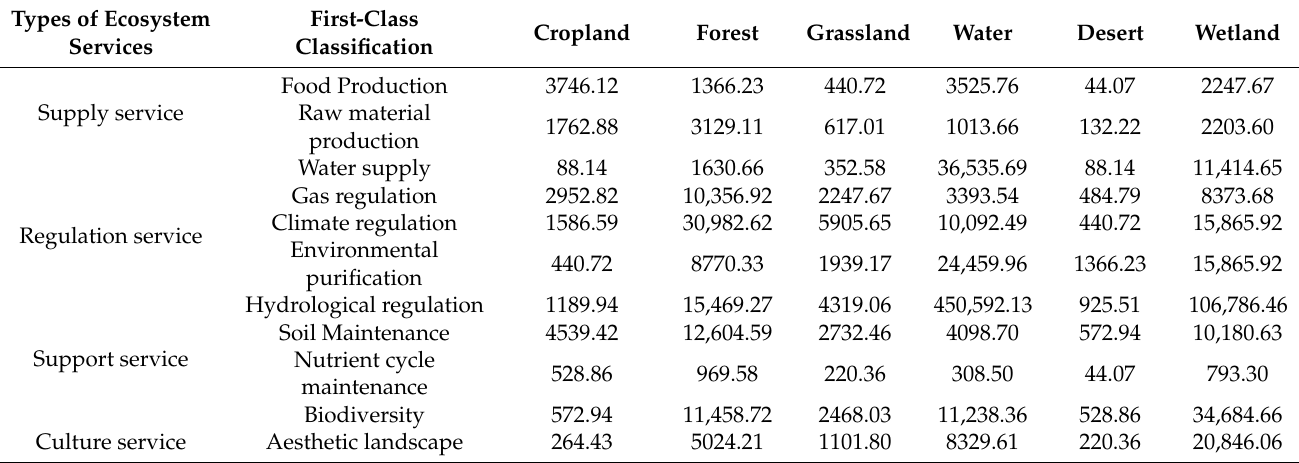
Table 2. Ecosystem service equivalent value per unit area of the Yarlung Zangbo river basin in 2020 (yuan · hm − 2